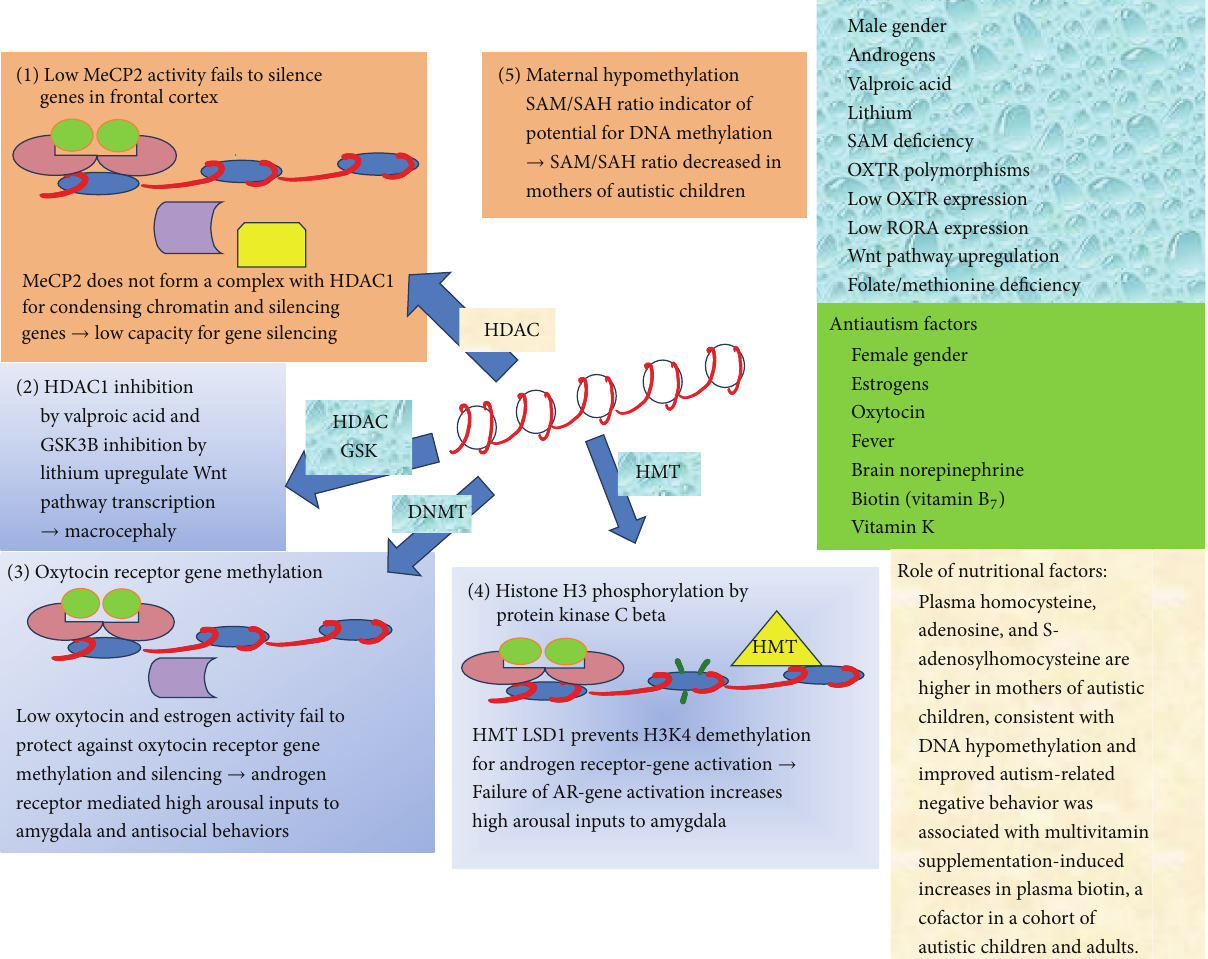
Figure 1: Main mechanisms of epigenetic alterations in autism. Each alteration involves many enzymes but the main players to cause methylation or acetylation are shown by arrows. These are not separate mechanisms and the enzymes do not act alone. Several enzymes act at a promoter simultaneously. (1) Low methyl CpG binding protein-2 (MeCP2) at CpG islands of frontal cortex reduces capacity for complexing with histone deacetylase 1 (HDAC1) for gene silencing. (2) HDAC1 inhibition by valproic acid exposure and glycogen synthetase kinase-3B (GSK3B) inhibition by lithium upregulate Wnt signaling pathway and activate transcription, associated with macrocephaly with increased number of cerebral cortical column. (3) DNA methyltransferase (DNMT) methylates oxytocin receptor gene produces low oxytocin and estrogen activity necessary for androgen receptor mediated high-arousal inputs to amygdala. (4) Histone H3 phosphorylation by protein kinase C beta activates the histone methyltransferase (HMT) lysine demethylase 1 (LSD1) which prevents demethylation of lysine-4 site of histone-3 (H3K4) that is also necessary for androgen receptor (AR) mediation of high arousal inputs to amygdala. (5) Maternal hypomethylation by dietary folic acid deficiency decreases availability of S-adenosyl methionine (SAM), associated with abnormal intrauterine